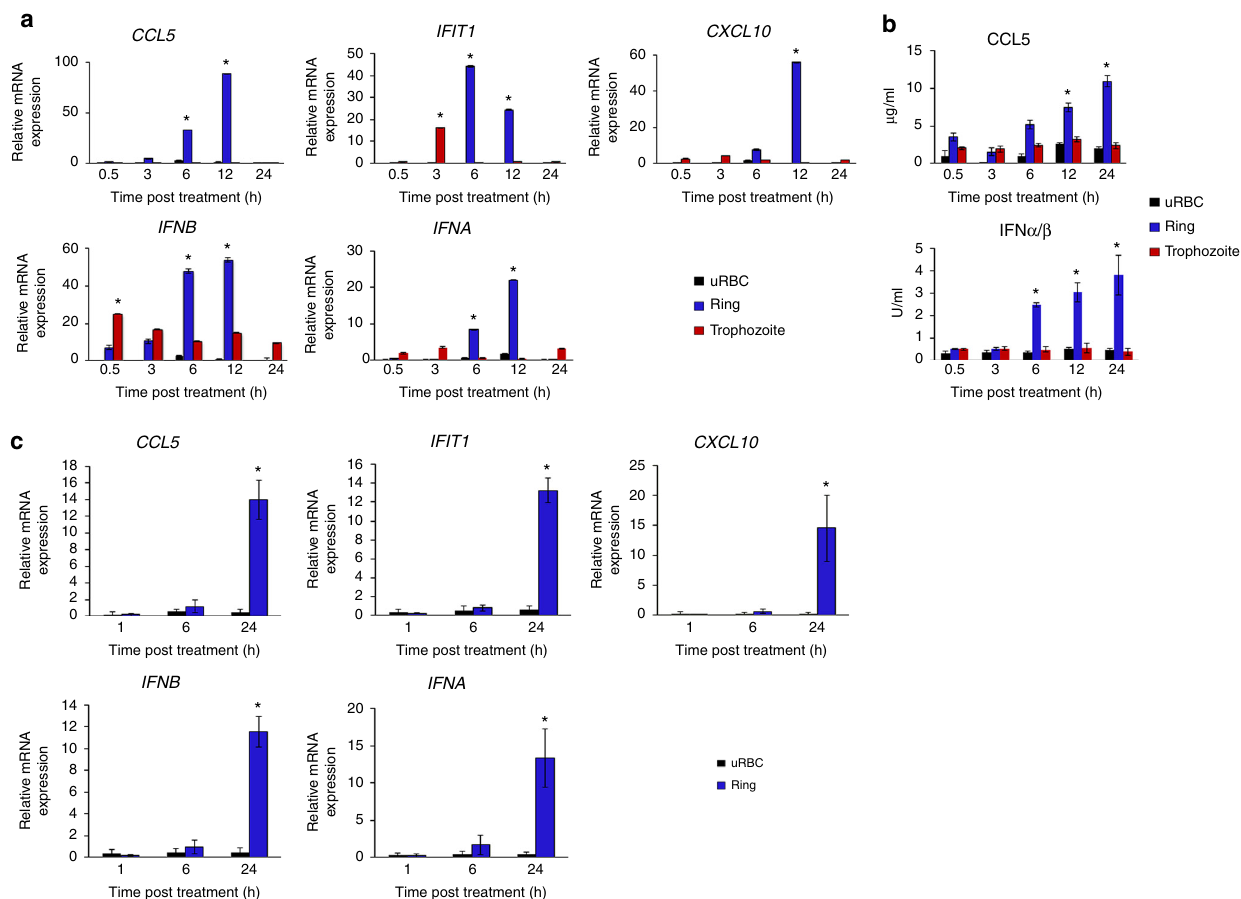
Fig. 6 Ring stage P. falciparum -EVs activate immune gene induction in monocytes. a THP-1 cells were incubated with P. falciparum ring-stage, trophozoite- stage or uRBC-derived vesicles for 30min, 3, 6, 12 and 24h. RT – PCR was performed for the products of IFNA, IFNB , CXCL10 , IFIT1 , and CCL5 . SD and T -test analysis * p ≤ 0.05. b THP-1 cells were incubated with P. falciparum ring stage, trophozoite-stage or uRBC-derived vesicles for 30 min, 3, 6, 12 and 24h. ELISA were performed for CCL5 and HEK blue IFN α / β . SD and T -test analysis * p ≤ 0.05. c Human primary CD14+ cells were incubated with P. falciparum ring stage-derived or uRBC-derived vesicles for 1, 6, and 24h. RT – PCR was performed for IFNA , IFNB , CXCL10 , IFIT1 , and CCL5 . SD and T -test analysis * p ≤